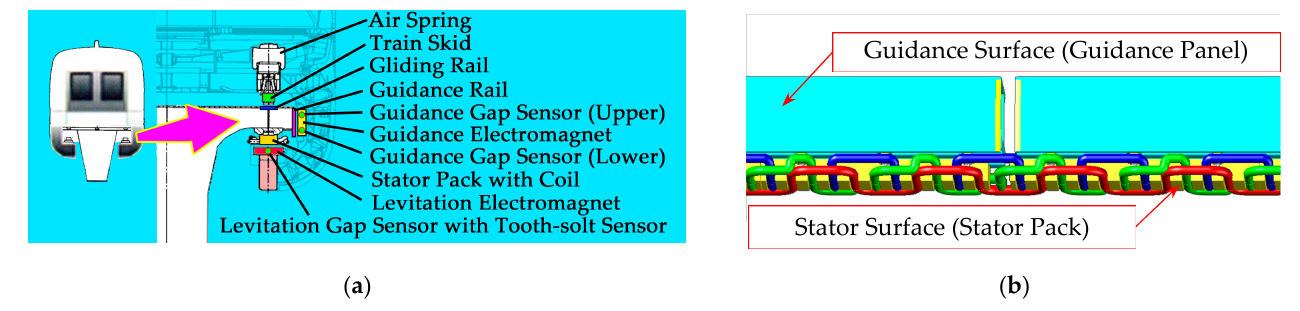
Figure 1. ( a ) Schematic diagram of the Transrapid maglev system; ( b ) surfaces of the maglev track.